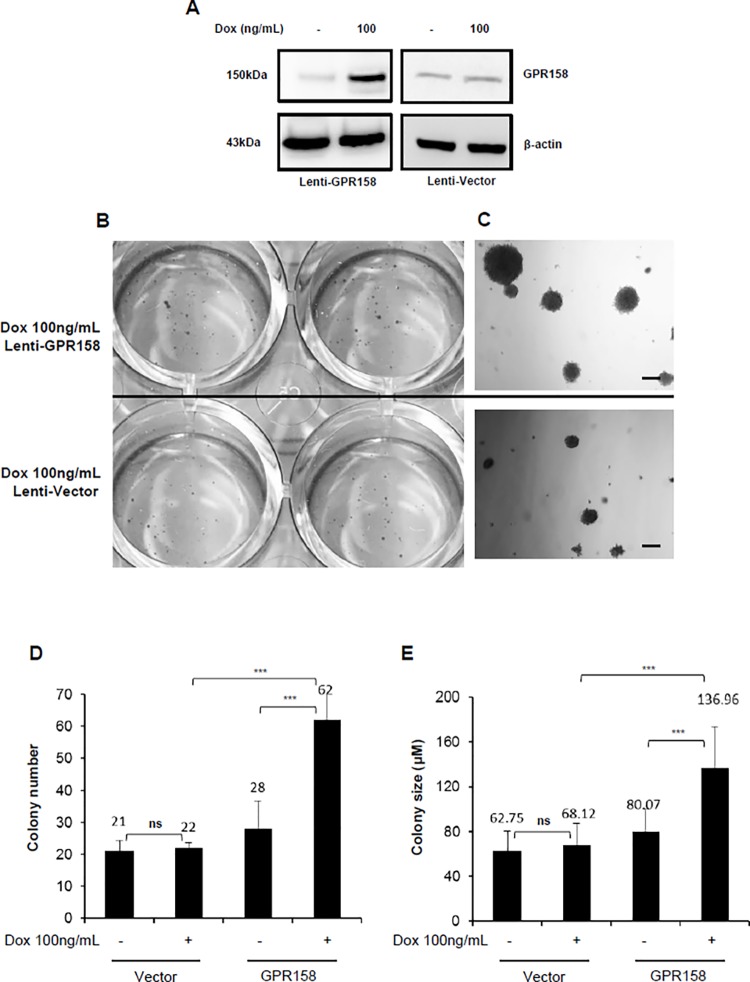
GPR158 effects on anchorage-independent colony formation in LNCaP cells.Soft agar anchorage-independent colony formation assay was performed as described in materials and methods using stably infected lenti-virus encoding either GPR158 (Lenti-GPR158) or vector control (Lenti-vector) LNCaP cells. (A) Lenti-GPR158 or lenti-vector LNCaP cells were treated with DOX 100ng/mL for 3-days. The whole cell lysates were subjected to western blot analysis using anti-ICD GPR158 antibodies. (B and C) The representative scanned images of culture wells (B) and microscopic images under 20x magnification (C) of crystal violet stained colonies formed at 14-days post-DOX treatment of lenti-GPR158 or lenti-vector cells are shown. The magnification bar represents 100 μM (D and E). The numbers of colonies were counted under the optical microscope (D) and their size was estimated using Nikon Eclipse Ti-E fluorescence microscope software (E) for all the indicated sample types. The data represent the mean ± SE of three independent experiments, with each experimental treatment performed in triplicate. ***p<.001; **p<.01, *p<.05; ns, p>.05.